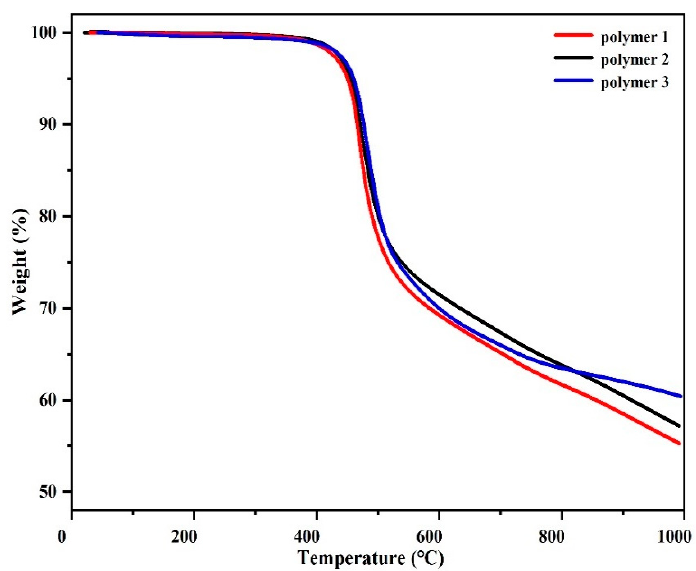
Figure 15. TGA of DPTP polymers in an inert atmosphere.